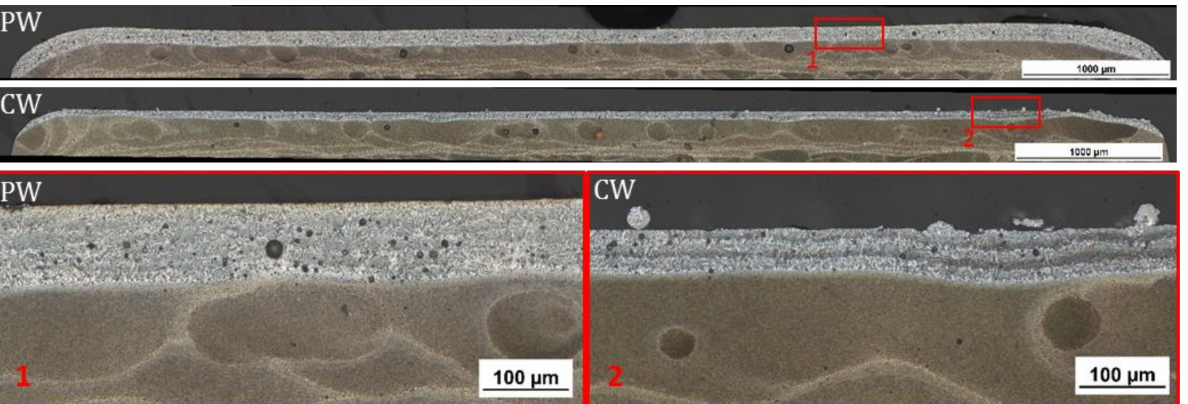
Figure 20. Etched cross section parallel to the y-z-plane of the polished tensile specimens at the centre of the tensile specimens near to the starting position of laser polishing.